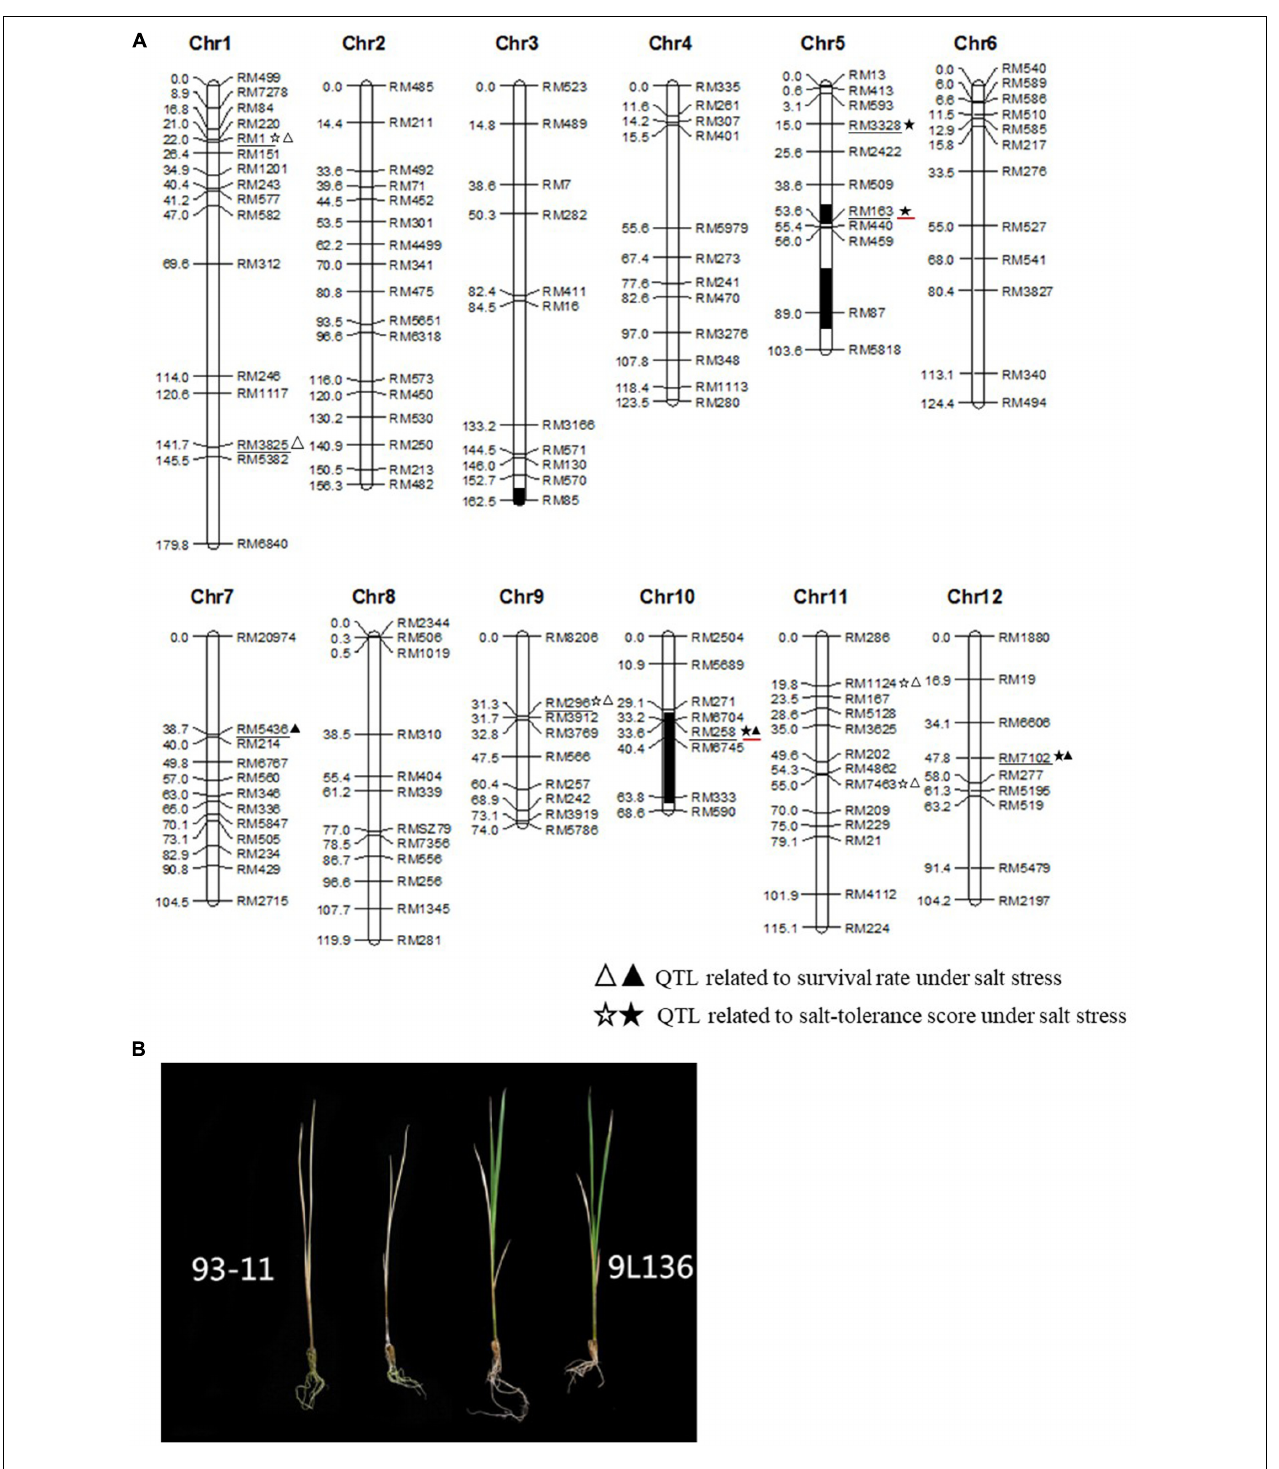
FIGURE 2 | Chromosomal location of salt tolerance-related QTLs (A) and the 9L136 and 93-11 phenotypes treated with 125 mM NaCl for 9 days (B) . Symbols on the right of chromosomes indicate the positions of putative QTLs for salt tolerance-related traits. The closed symbols indicate that the O. rufipogon -derived alleles conferred a positive effect on salt tolerance-related traits, and the open symbols indicate a negative effect. The markers related to QTLs for salt tolerance are underlined with black. In the graphical genotypes, the black regions indicate homozygous regions from Chaling common wild rice in 9L136 and the white regions indicate homozygous regions for recurrent parent 93-11. The QTLs enhancing salinity tolerance and located on the introgressed region in 9L136 are underlined with red.